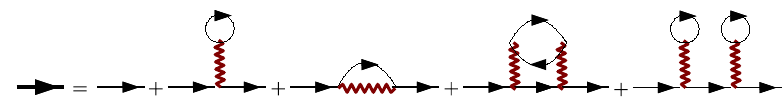
Figure 13. The first few diagrams for the Hubbard model single-particle Green’s function. Here, the solid black line with an arrow represents the single-particle Green’s function and the wavy line the Hubbard U